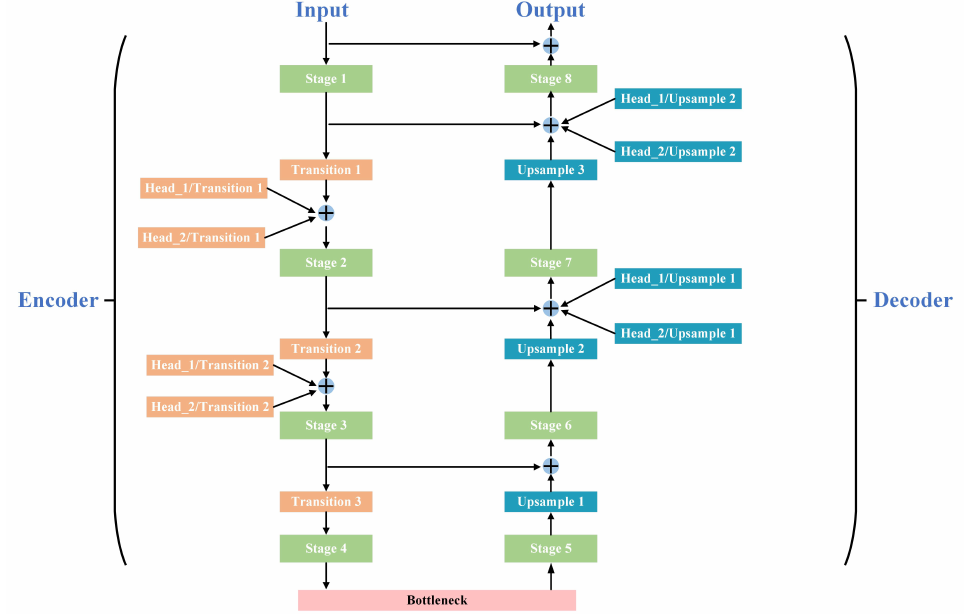
Figure 4. The architecture of Head 3 . An elementwise fusion is performed with the outputs of Head 1 and Head 2